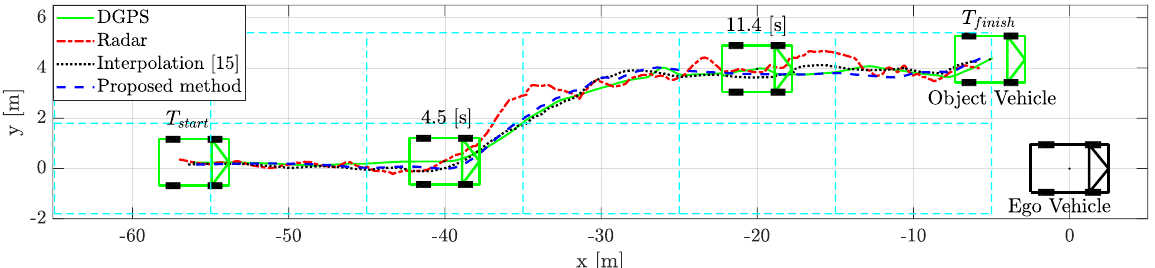
Figure 8. Scenario-based relative movement of object estimation from the top view: when estimated with a commercial radar, the longitudinal and lateral position errors (between − 37 and − 33 m) and lateral position error (between − 17 and − 15 m) occurred due to latency and measurement uncertainty.